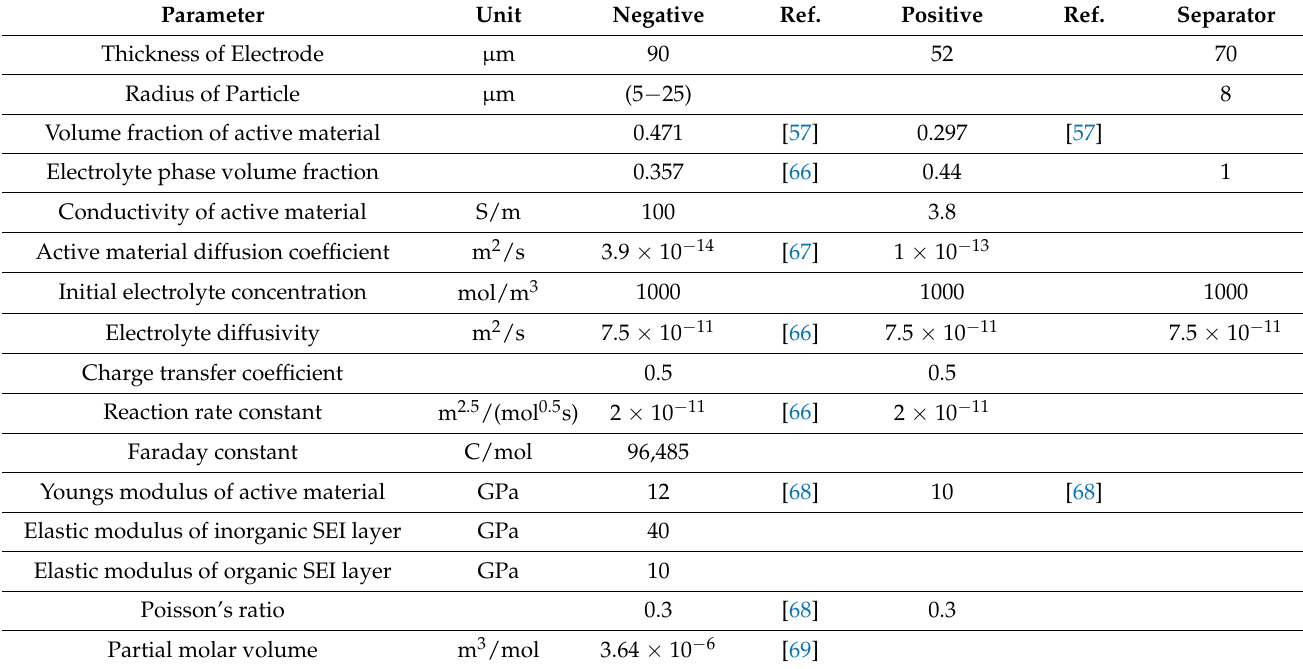
Table 1. Parameters for the Cell